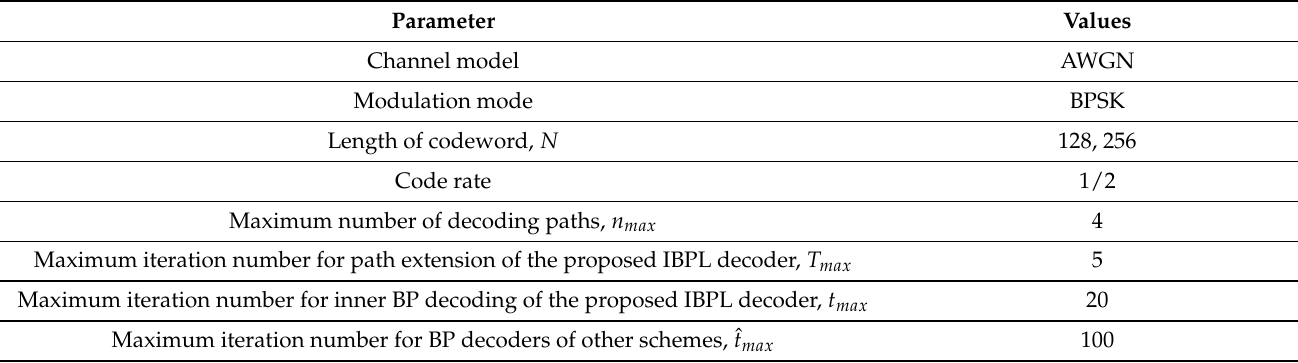
Table 1. System Simulation Parameter Settings.